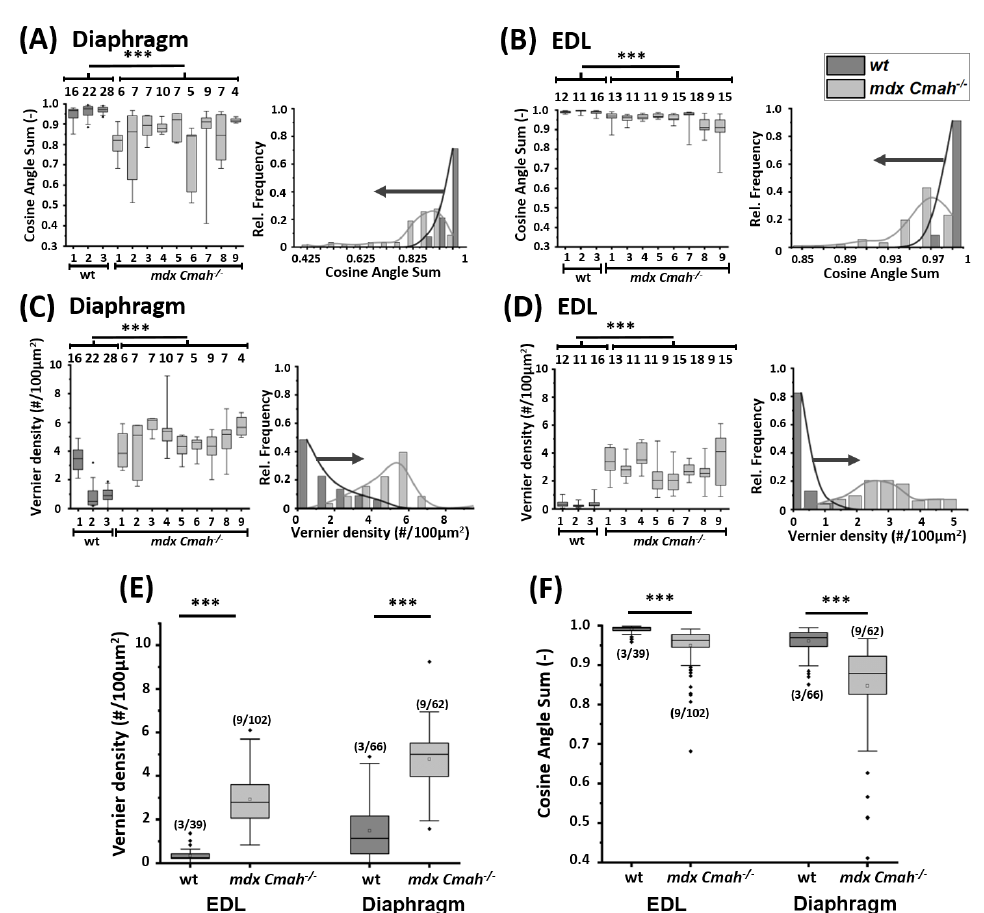
Figure 6. Myofibrillar cytoarchitecture is severely compromised and disordered in single fibers from EDL and diaphragm from adult mdx Cmah − / − over wt mice. Diaphragm and EDL muscle fibers show a highly significant shift toward decreased CAS ( A , B ) and increased VD values in mdx Cmah − / − mice ( C , D ). Combined results are shown in ( E , F ). Abscissa numbers correspond to the individual label of each experiment (***: p < 0.001). (m/n) relates to animals/muscle single